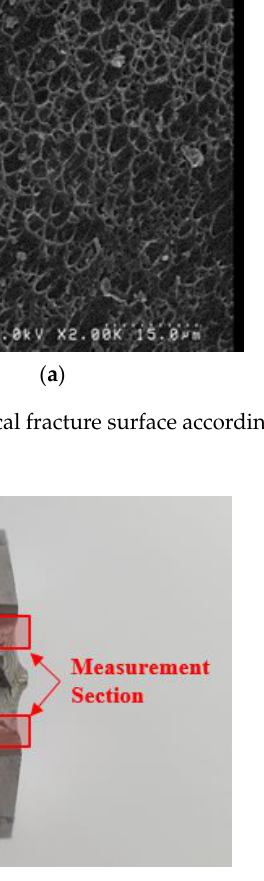
Figure 6. Definition of measurement section for impact specimens.